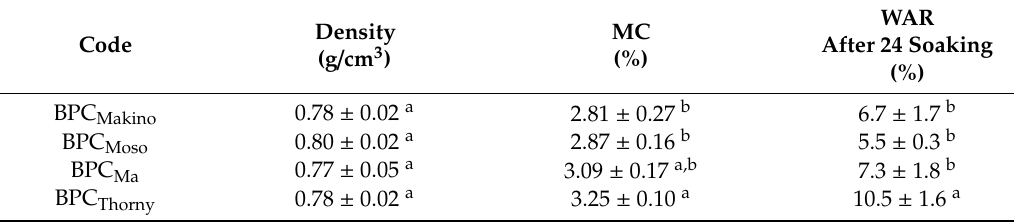
Table 4. Physical properties of the BPCs with various BFs.